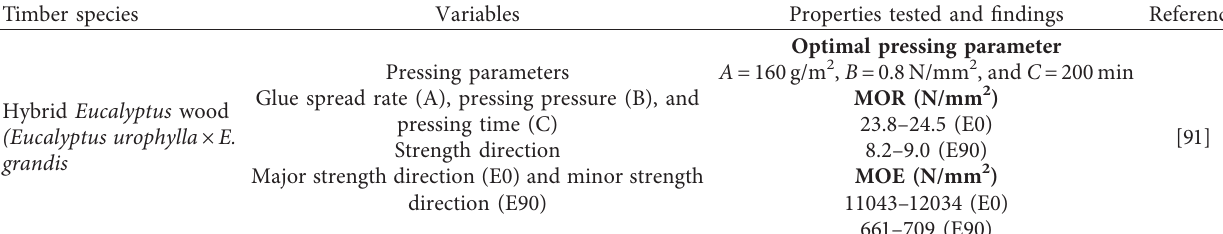
Table 2: Studies on CLT made from Eucalyptus